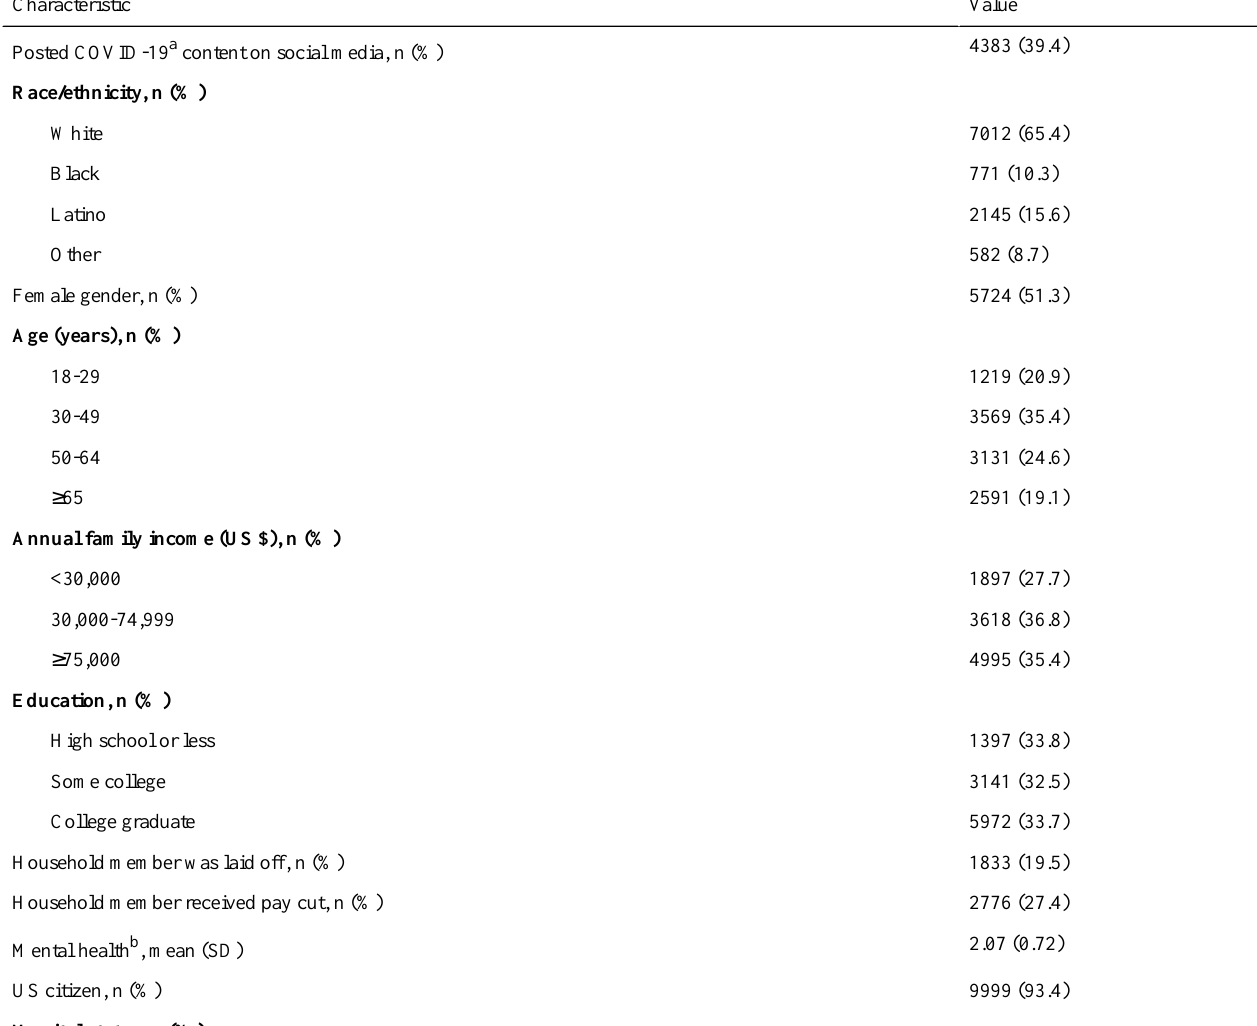
Table 1. Characteristics of sample respondents